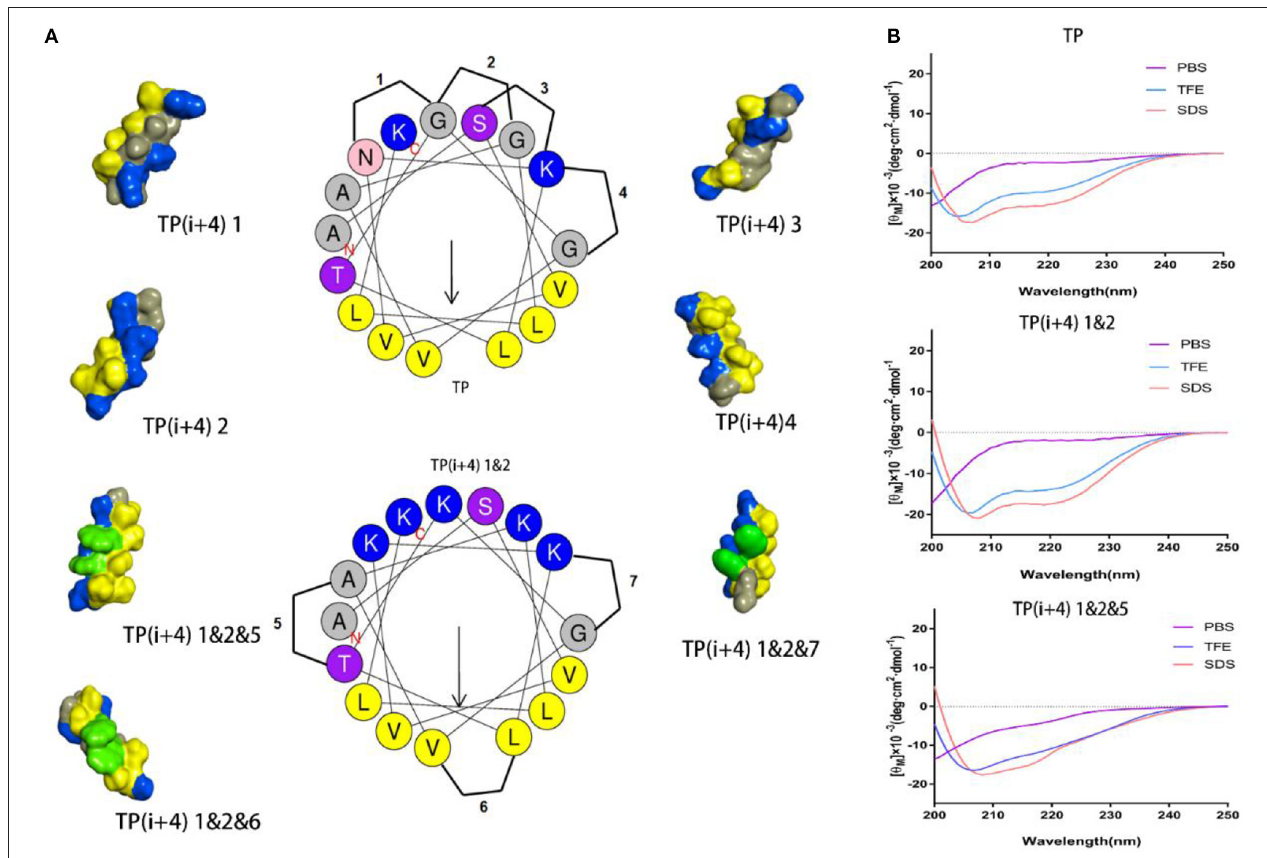
FIGURE 1 | (A) Helical wheel projections of the TP and TP(i + 4) 1&2, and schematic diagrams of alternate positions. The three-dimensional structure of these peptides was predicted on I-TASSER (Yang and Zhang, 2015), where blue represents positively charged amino acids, yellow represents hydrophobic amino acids, green represents Trp replacement sites, and gray represents other amino acids. (B) CD spectra of the TP, TP(i + 4) 1&2, and TP(i + 4)